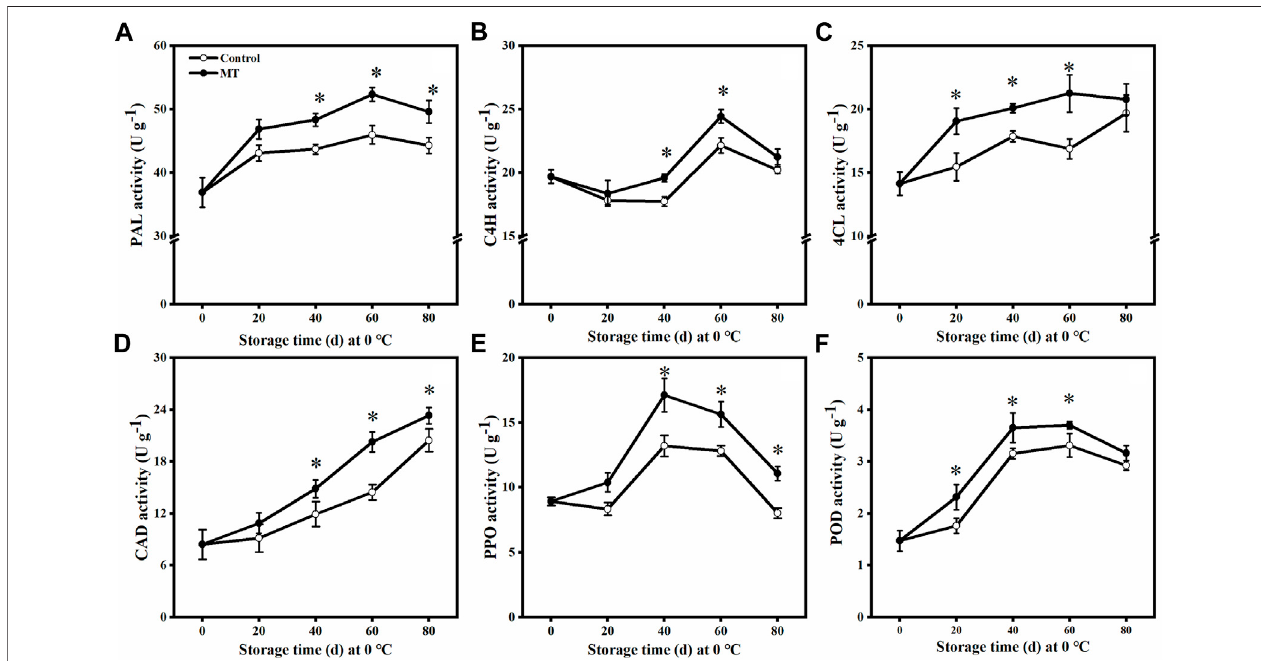
FIGURE3| EffectsofMTtreatmentonPAL (A) ,C4H (B) ,4CL (C) ,CAD (D) ,PPO (E) ,andPOD (F) activitiesofblueberryfruitsduringthepostharveststorageat0 ° C. Here, symbol * indicates signi fi cant differences ( p < 0.05). Data are presented as the mean ± SD.